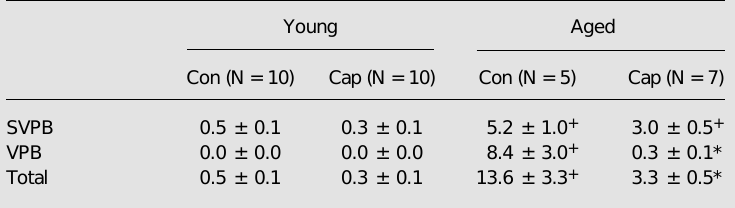
*P<0.05 vs untreated aged rats (Kruskal-Wallis ANOVA test). + P<0.05 vs young rats (Kruskal-Wallis ANOVA